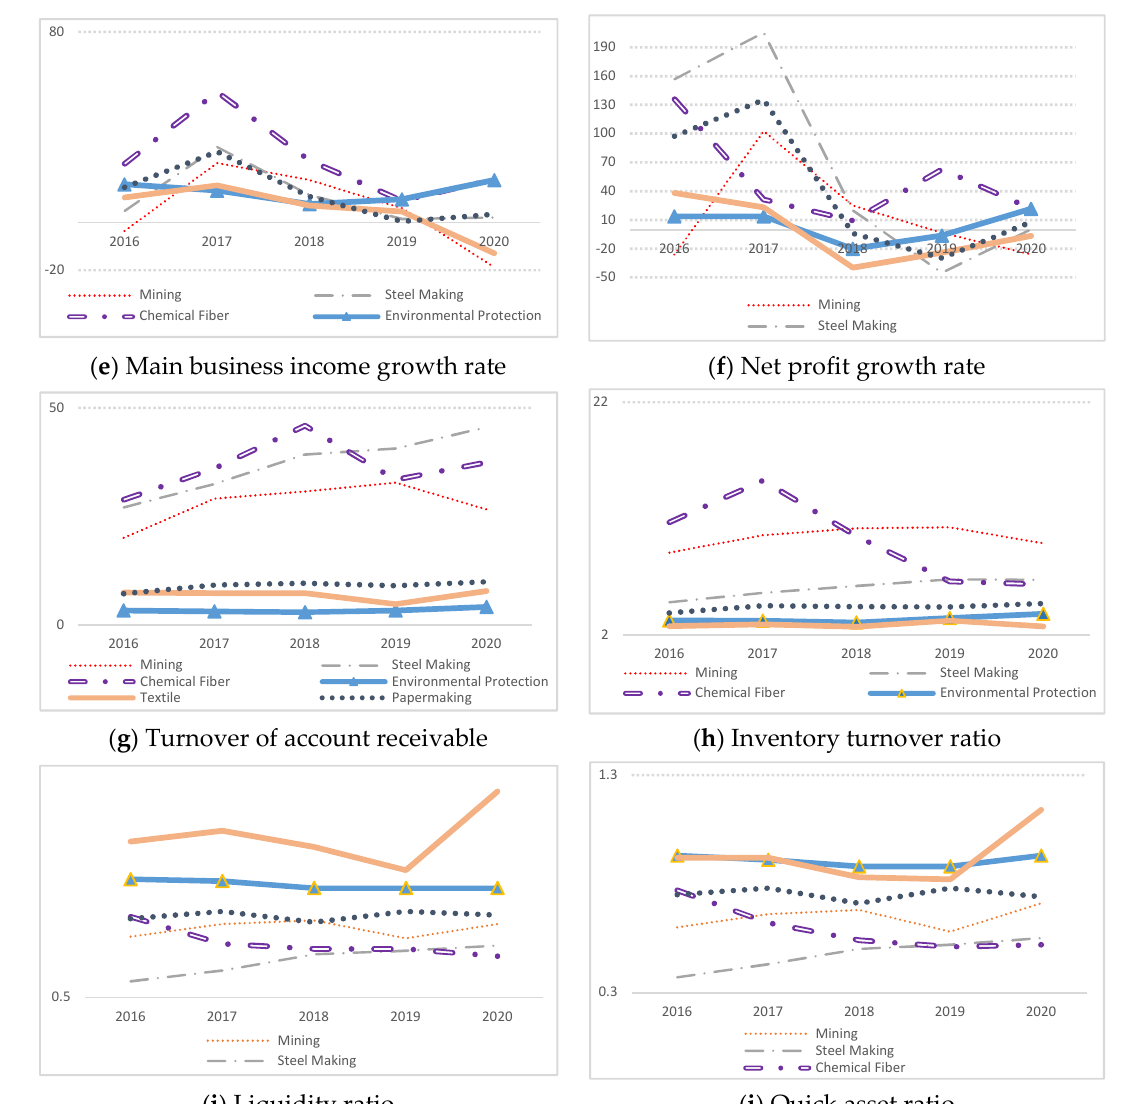
Figure 1. Financial comparison between green industries and the “Two High and One Surplus” industries.